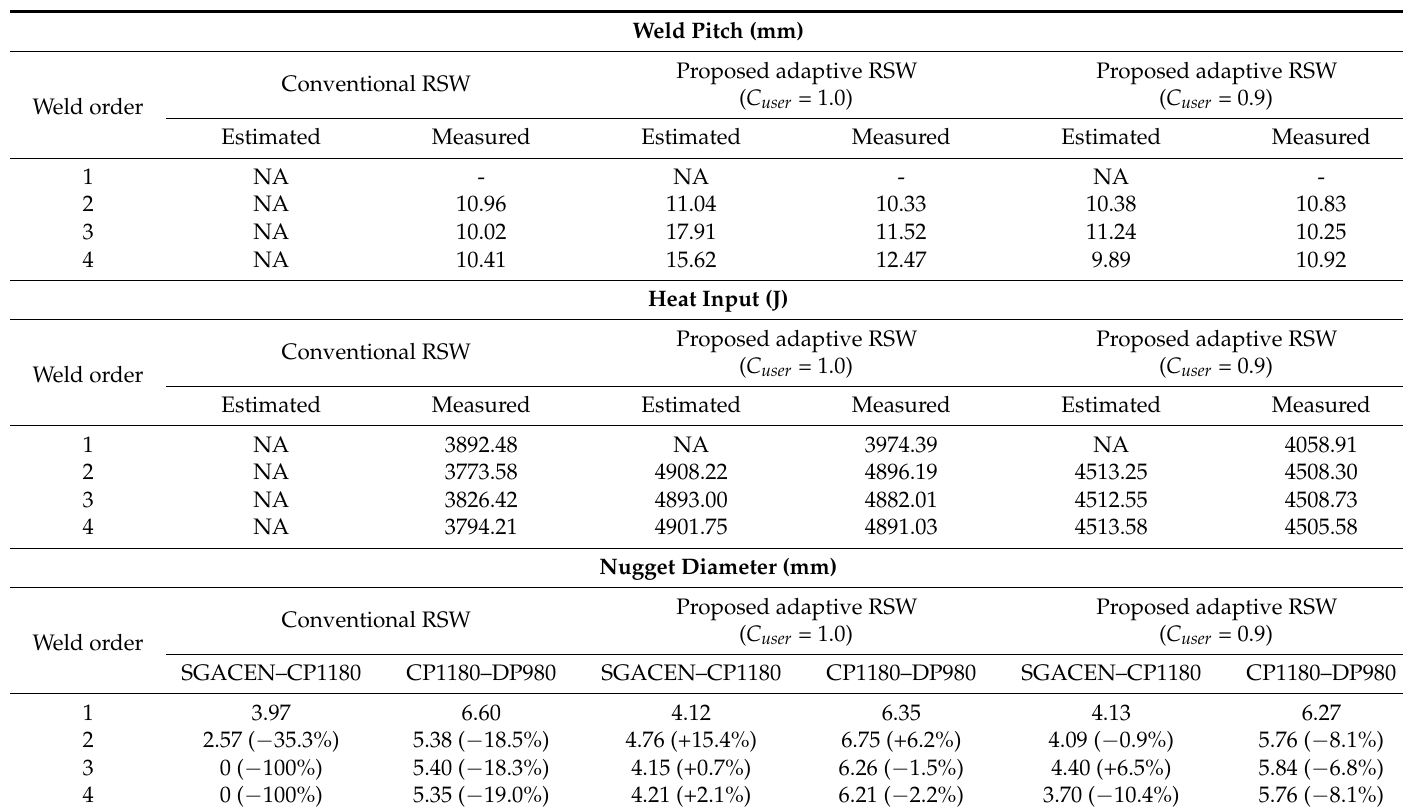
Table 3. Comparison of various weld pitch, heat input, and nugget diameter parameters using conventional and proposed adaptive RWS